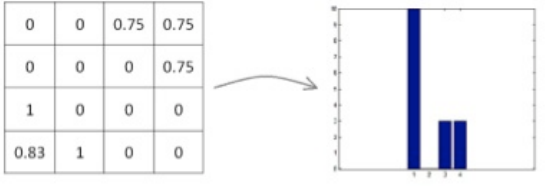
Figure 8: Histogram of local patch